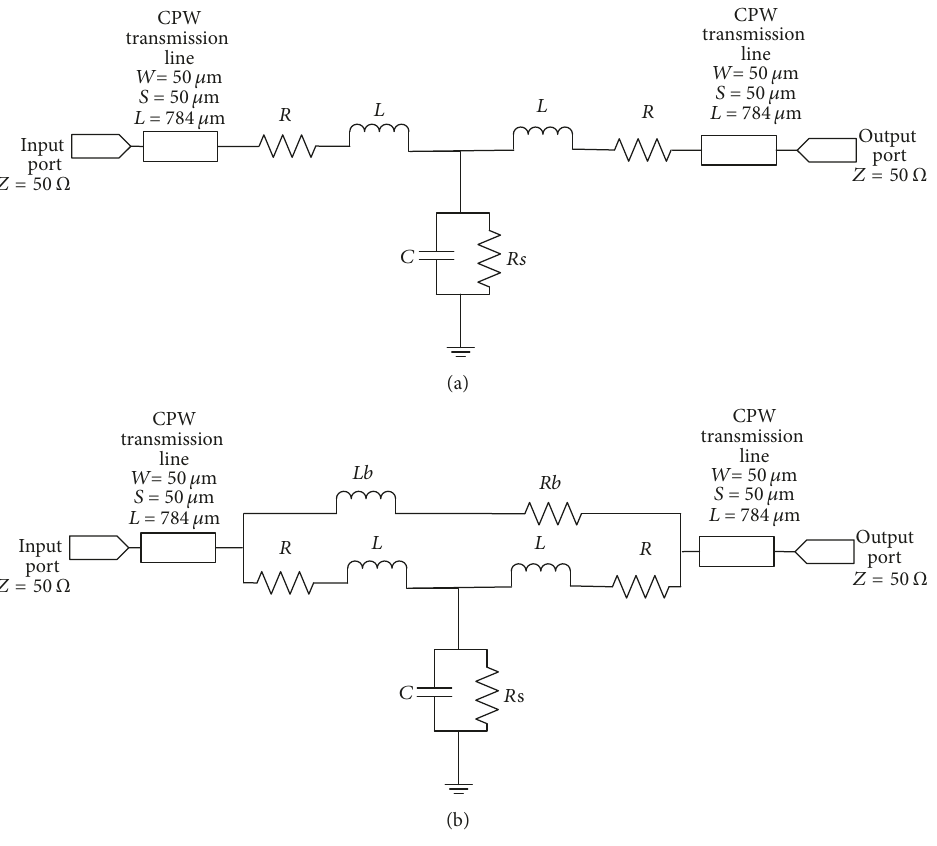
Figure 5: The (a) equivalent electrical model for single line coil inductor structure and (b) equivalent electrical model for dual line coil inductor